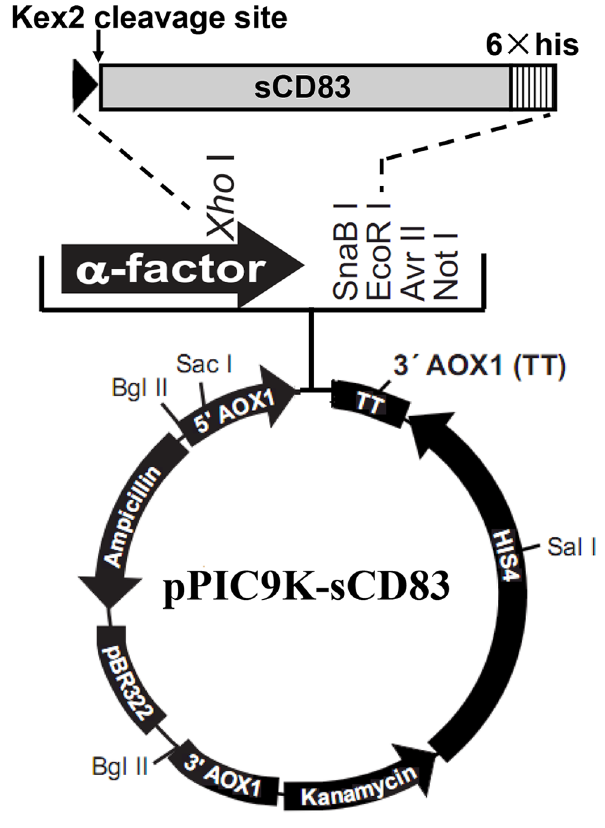
Figure 1. A schematic genetic map of the sCD83 expression vector. The sCD83 gene was inserted between the Xho I and Eco R I sites in pPIC9K and in-frame with the Kex2 cleavage site in the sequence of the a -factor secretion signal to create the expression vector pPIC9K-sCD83.